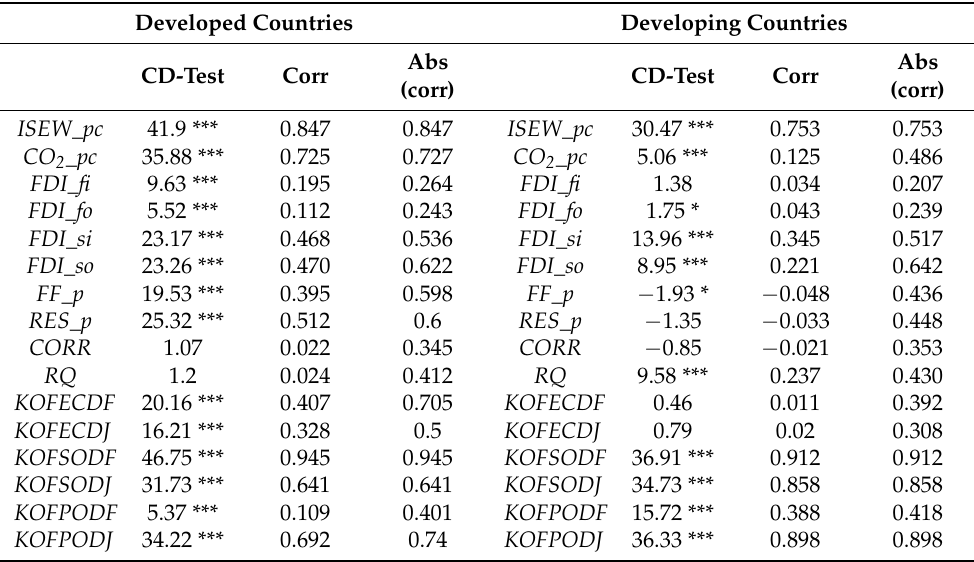
Table 6. Cross section dependence test from 2000 to 2017 (ISEW